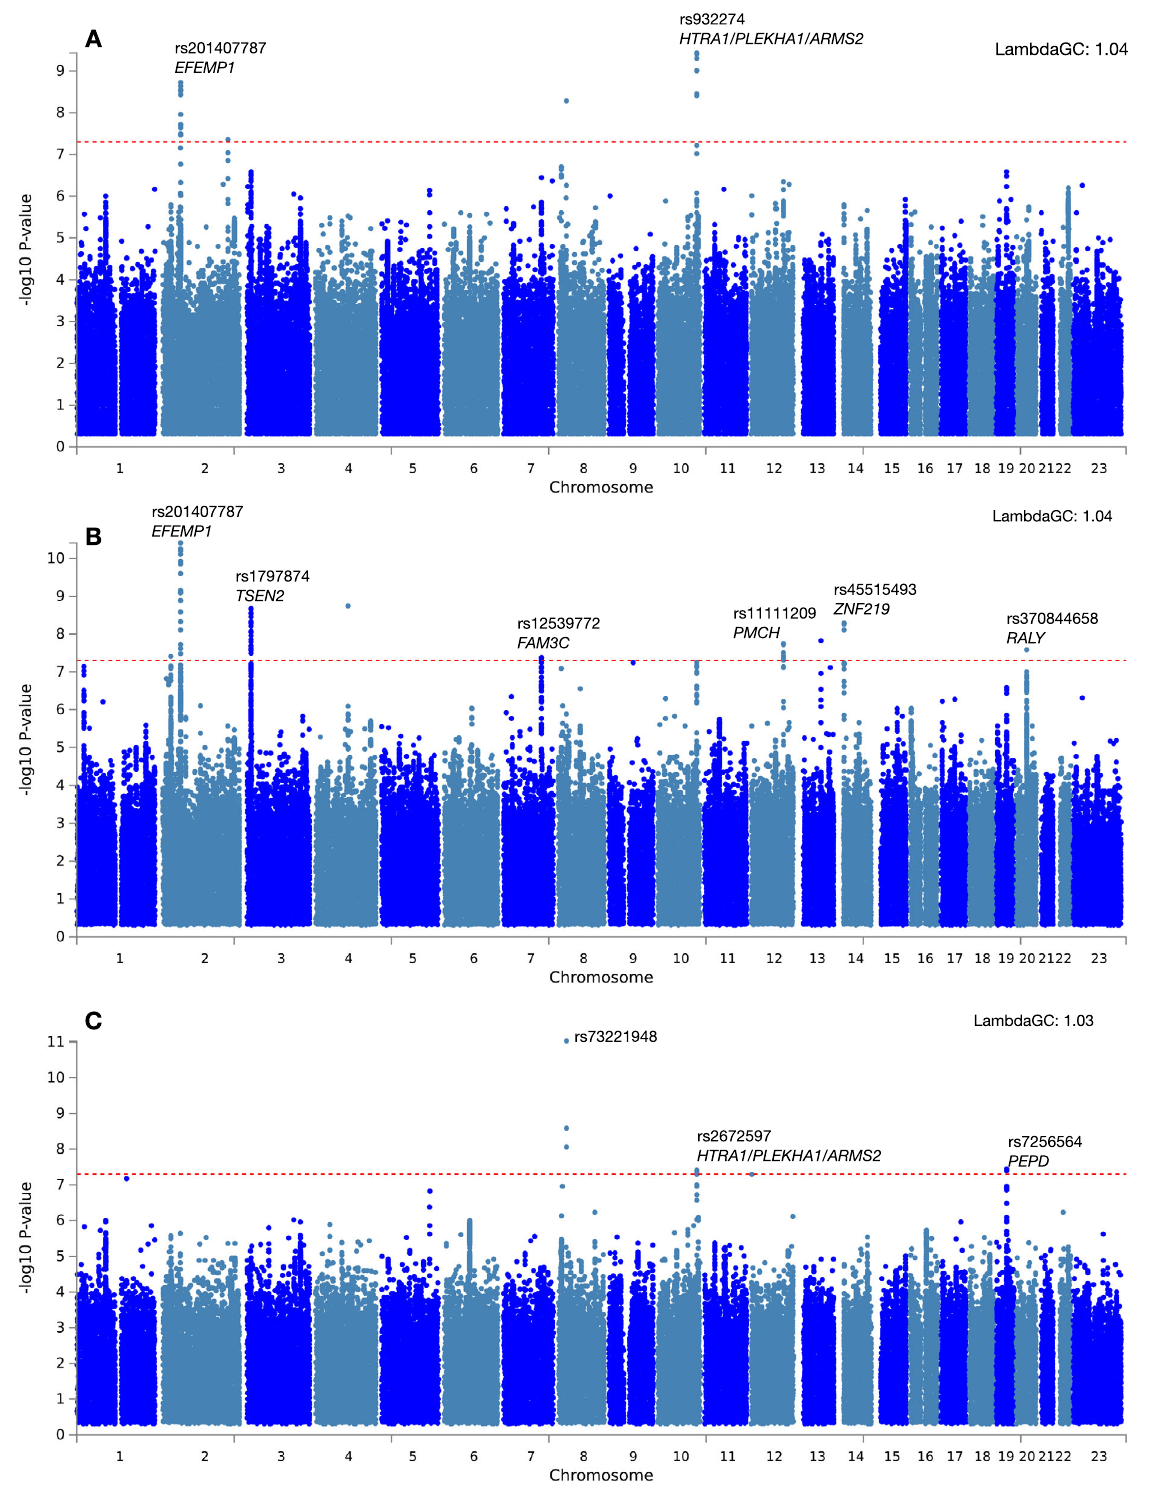
Fig. 5 -log10(pvalue) vs. chromosomal position: GWAS on AbdAge, Liver, and Pancreas Accelerated Age. A GWAS results for accelerated abdominal aging (AbdAge); Lambda GC:1.04. Sample size: 32,475. B Liver Accelerated Age. Lambda GC: 1.04; Sample size: 40,760 and C Pancreas Accelerated Age. LambdaQC: 1.03; Sample Size: 32,548;-log10( p -value) vs. chromosomal position of locus. Dotted line denotes 5 × 10 − 8 . All GWAS p values reported are 2-sided and not corrected as shown for multiple comparisons; however, all results lower than 5 × 10 – 8 achieved Bonferroni-level of signi fi